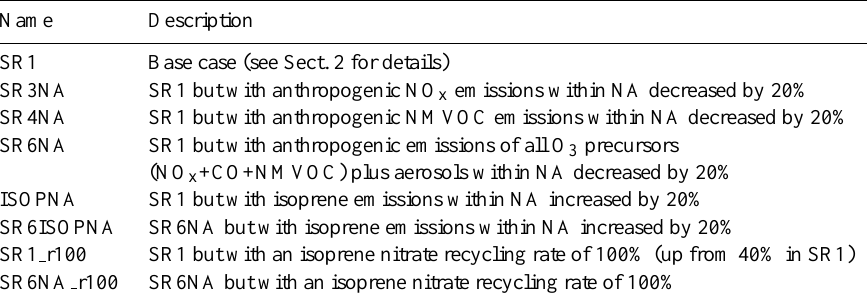
Table 1. MOZART-2